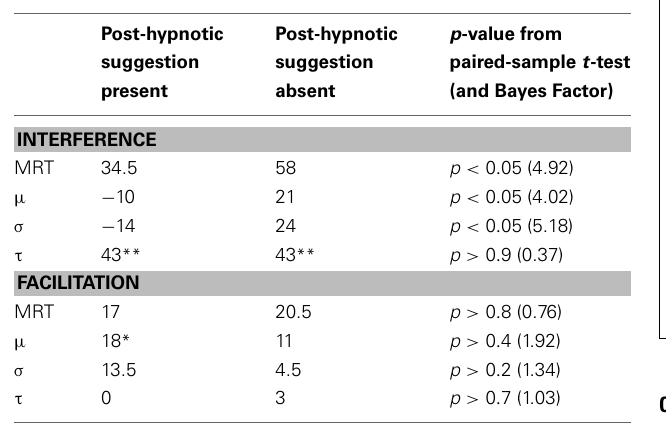
Table 4 | Algebraic means and estimates of μ , σ , and τ for Stroop interference and facilitation (ms) as a function of condition when collapsing across Response-Stimulus Interval.